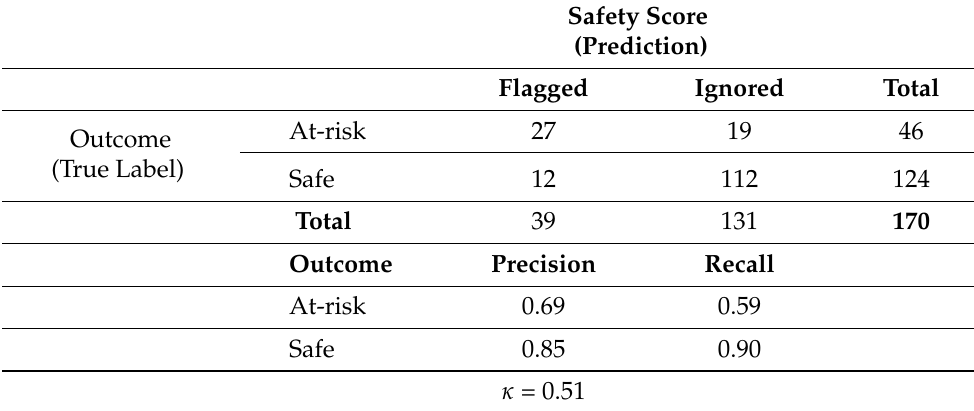
Table 17. Confusion matrix and summary of B-PM test set